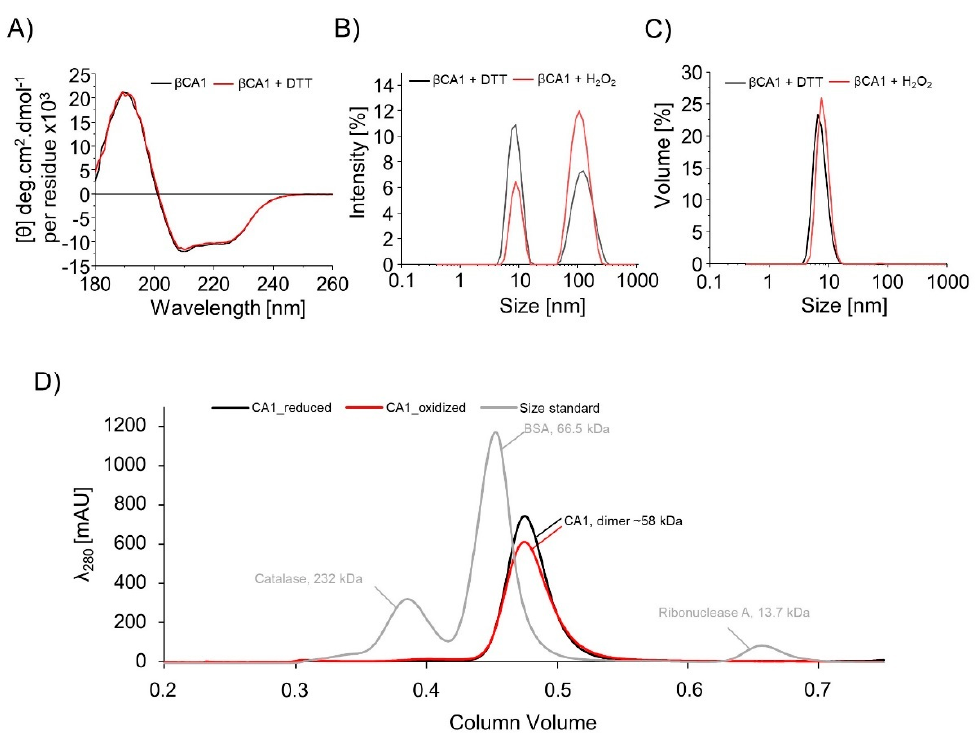
Figure 2. Determination of the oligomeric state of β CA1. ( A ) Superimposed far UV spectra of β CA1 with or without 10 mM DTT. ( B ) Dynamic light scattering (DLS) curves representing the β CA1 light diffusion intensity as function of the size in nm and ( C ) the β CA1 volume signal as function of the size in nm. β CA1 (320 µM) was analyzed by DLS after treatment with 20 mM DTT and 500 µM H 2 O 2 , respectively. ( D ) Size exclusion chromatography of β CA1 after treatment with 50 mM DTT and re-oxidation with 100 µM H 2 O 2 . Reduced β CA1 is shown as black line and oxidized β CA1 is shown as red line, size standard of the SEC run is shown in gray.